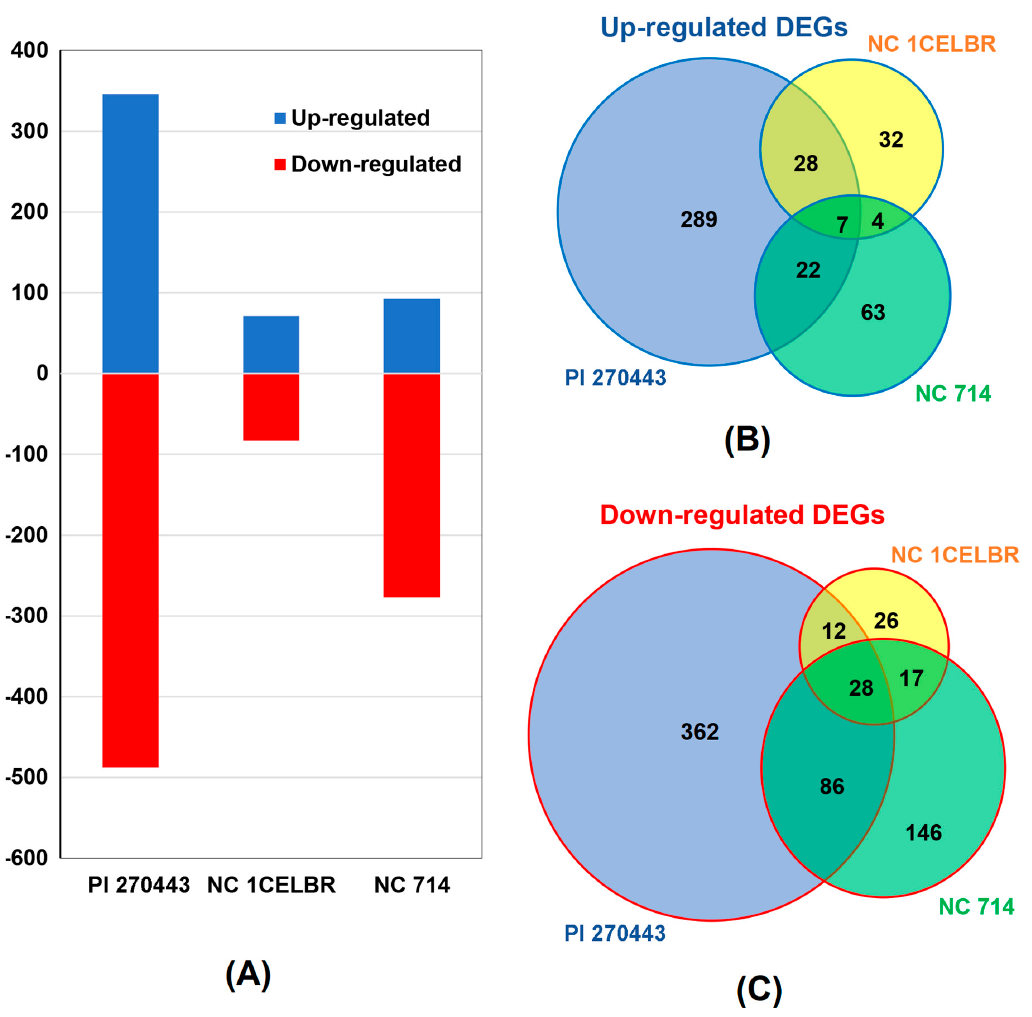
Figure 3. DEGs in three tomato lines induced by BS inoculation. ( A ) The number of upregulated (blue bar) and downregulated DEGs (red bar, with the label of “-”) in tomato lines with respect to the inoculation of X. perforans race T4. ( B , C ) Venn diagram showing the upregulated (blue outlined) and downregulated (red outlined) differentially expressed genes (DEGs) in three tomato lines PI 270443, NC 1CELBR, and NC 714. An entire list of differentially expressed genes (DEGs) in all three tomato lines is provided as supplementary material (Table S1).